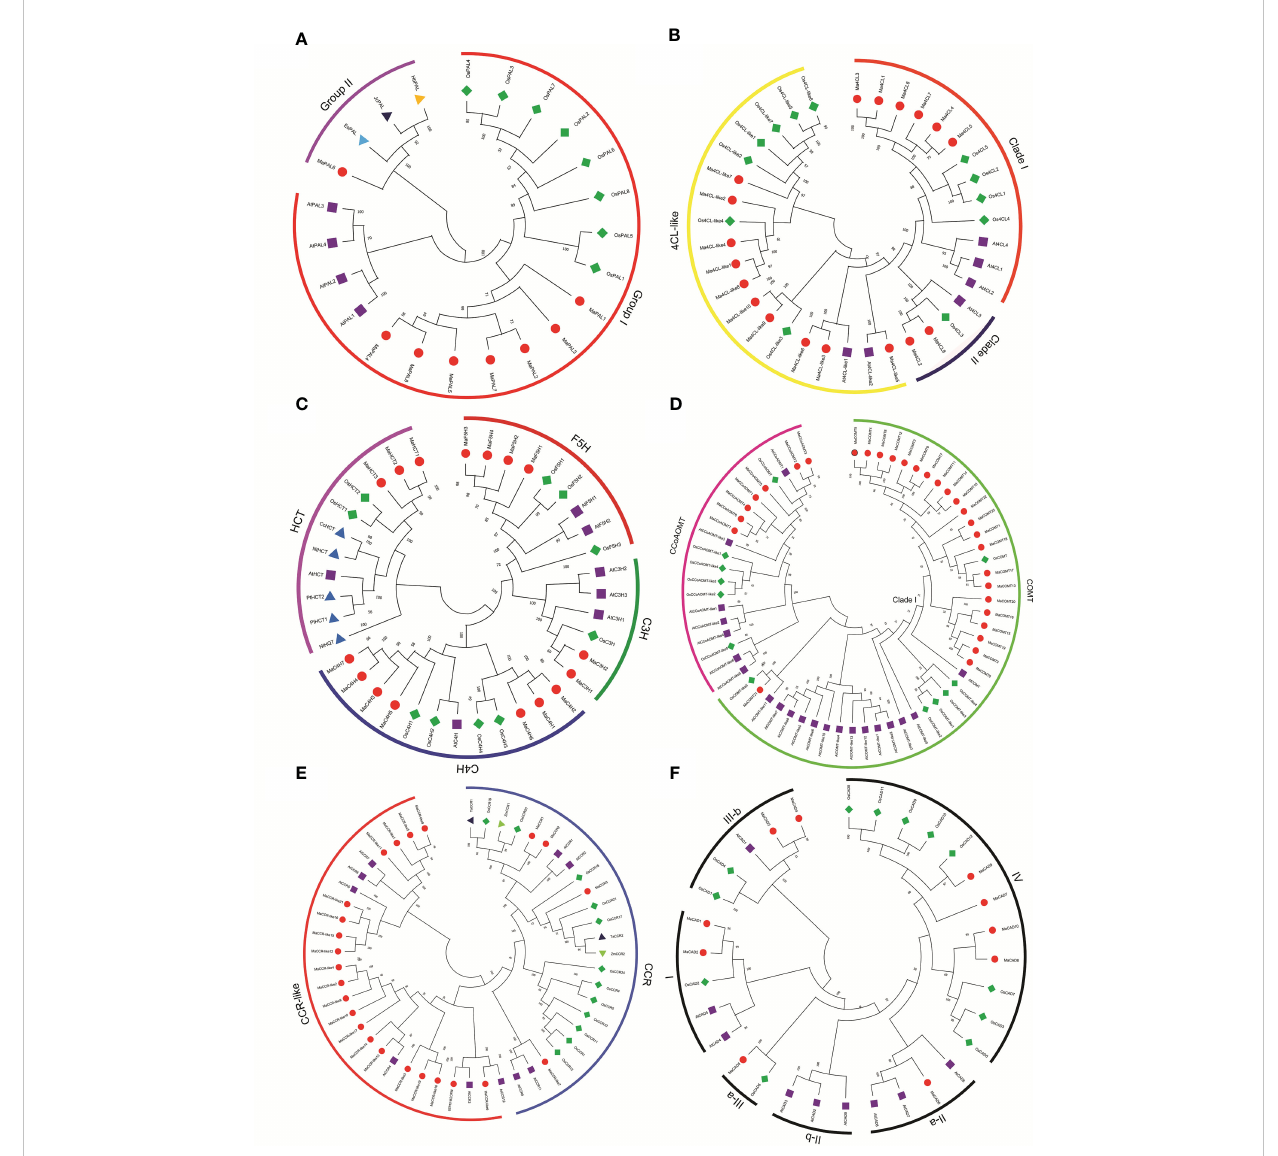
FIGURE 2 Phylogenetic relationship of lignin biosynthesis genes in Musa acuminata (red dot), Arabidopsis (purple square), rice (green diamond), and other plants (triangle). The Maximum Likelihood (ML) tree was drawn using MEGA 6.0 with 1000 bootstrap replicates. (A) Phenylalanine ammonialyase (PAL), (B) 4-coumarate: CoA ligase (4CL), (C) hydroxycinnamoyl-CoA shikimate/quinate transferase (HCT), coumarate 3-hydroxylase (C3H), cinnamate 4-hydroxylase (C4H) and ferulate 5-hydroxylase (F5H), (D) caffeic acid Omethyltransferase (COMT) and caffeoyl-CoA-O- methyltransferase (CcoAOMT), (E) cinnamoyl CoA reductase (CCR), (F) cinnamyl alcohol dehydrogenase